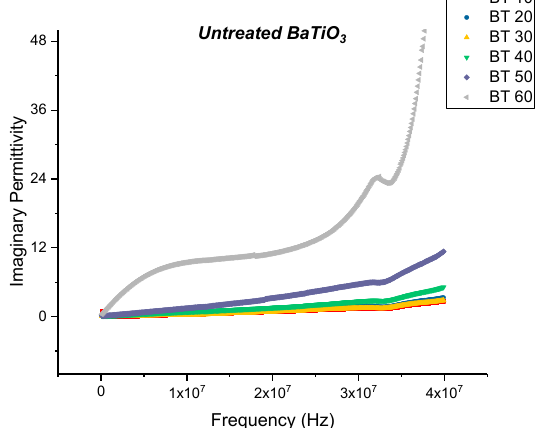
Figure 4. The dielectric loss of the BaTiO 3 -epoxy composite that were fabricated using untreated BaTiO 3 nanoparticles is plotted as a function of frequency where the volume fraction of BaTiO 3 is varied from 0.1 to 0.6. The maximum dielectric loss at 20 MHz was recorded to be 11.06 at a volume fraction of 0.6 of BaTiO 3.